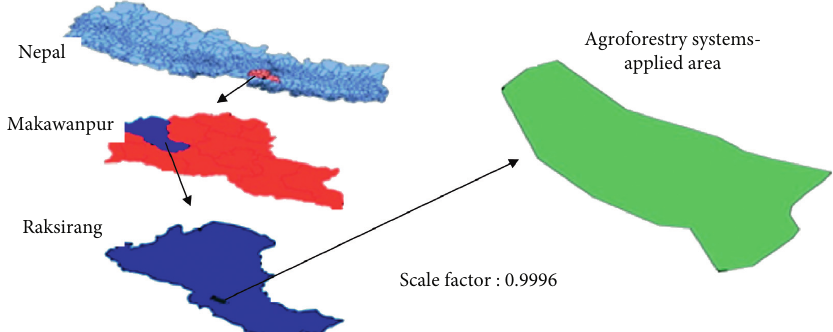
Figure 1: Map showing the agroforestry system-applied area in Raksirang Rural Municipality, Makawanpur,